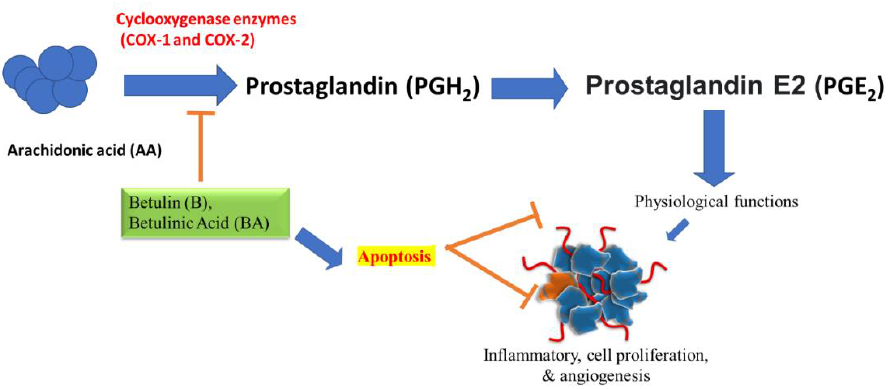
Figure 5. Action of Betulin (B) and Betulinic Acid (BA) on cyclooxygenase enzymes (Cox-1 and Cox-2) which convert the arachidonic acid to prostaglandins. Inhibition of prostaglandin PGE 2 derived from Cox-2 by blocking its pathway through Betulin (B) and Betulinic Acid (BA) leads to inhibition of angiogenesis, proliferative